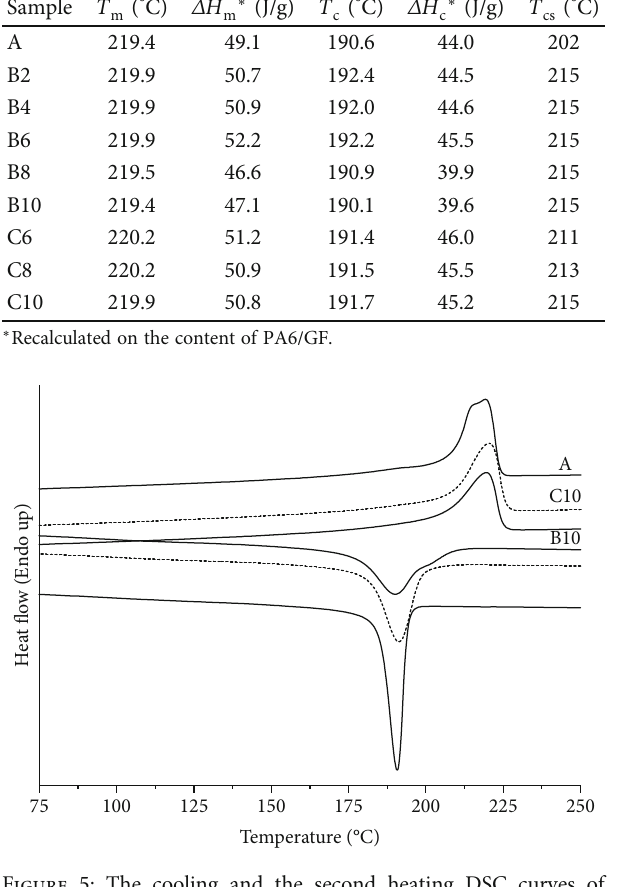
Figure 5: The cooling and the second heating DSC curves of composites: PA6/GF (A), PA6/GF/10%EG5(B10), and PA6/GF/ 10%EG1000